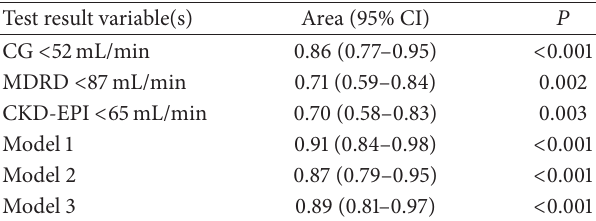
Table 5: ROC curve analysis for CKD (24h creatinine clearance < 60mL/min). Test result